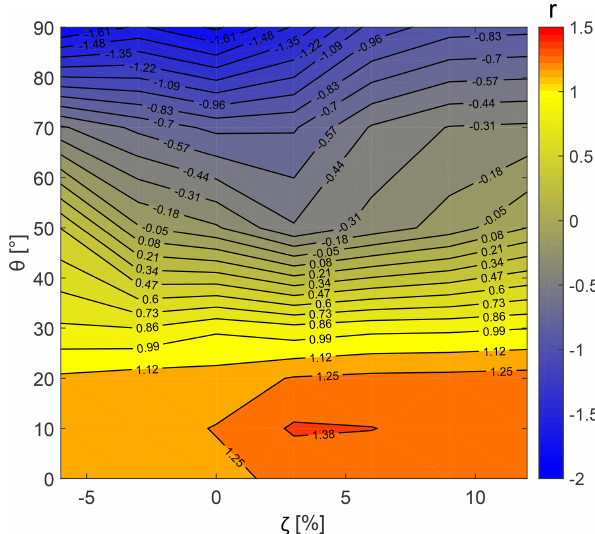
Figure 12. Effect of variable radial gap and the flap deflection angle on the power augmentation factor using the RANS